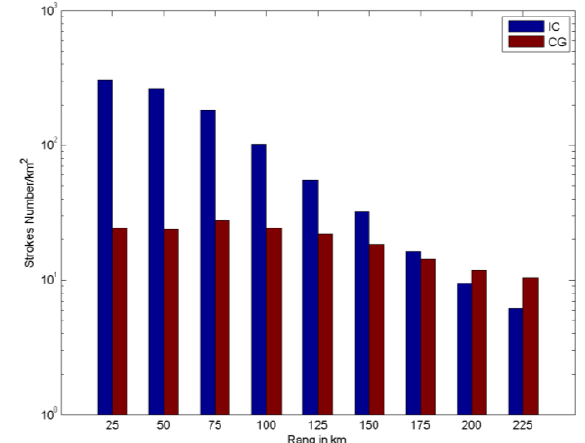
Figure 10. Distribution of located IC and CG strokes from May to October in 2014. Each bin in the figure represents a normalized number of strokes that occurred within a 25-km-wide concentric ring around the center station (CCJ). Flash numbers are normalized to unit area (1 km 2 ) at each range.